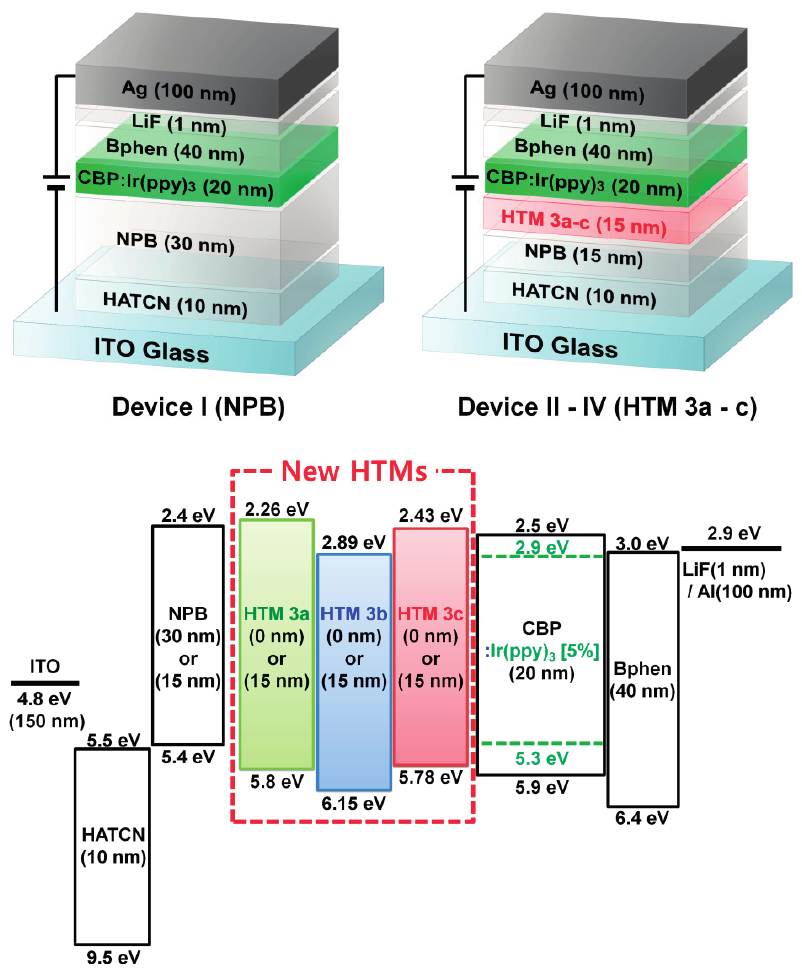
Figure 2. Device structures of designed HTMs 3 and their energy diagrams.